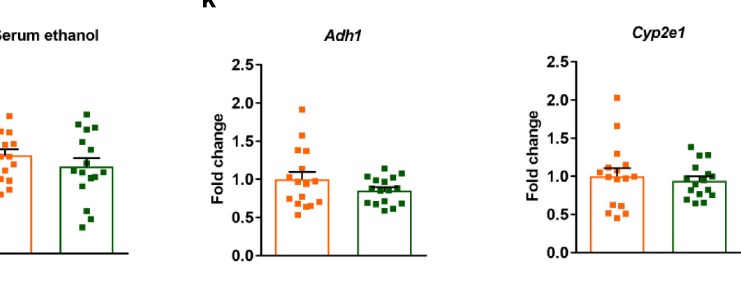
Fig. 5 Extracellular region of CRIg protects mice from ethanol-induced liver disease. WT mice were fed the chronic – binge ethanol diet. a One hour after the ethanol binge, mice were given intravenous injections of control-Ig or CRIg-Ig (12 mg/kg body weight [BW]) and gavaged with E. faecalis (5 × 10 9 CFUs). Bacterial load was determined 20 min after bacterial gavage. b – k One day before the ethanol binge, mice were given intravenous injections of control-Ig or CRIg-Ig (12 mg/kg body weight [BW]). b Serum levels of ALT. c Hepatic triglyceride content. d Representative oil red O-stained liver sections. e – g Hepatic levels of mRNAs encoding in fl ammatory cytokines and chemokines IL1B, CXCL1, and CXCL2. h Serum levels of in fl ammatory cytokines and chemokines TNF and CXCL1. i Hepatic level of mRNA encoding CRIg . j Serum levels of ethanol. k Hepatic levels of Adh1 and Cyp2e1 mRNAs. Scale bar = 100 μ m. Results are expressed as mean ± s.e.m ( a – c , e – k ). P values determined by two-sided Student ’ s t -test ( a – c , e – k ). * P < 0.05, ** P <